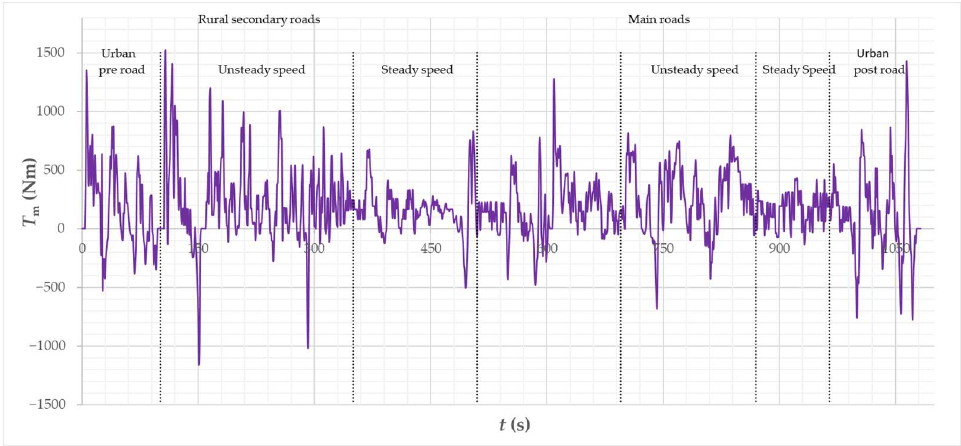
Figure 22. Vehicle torque waveform of the Artemis Road cycle .